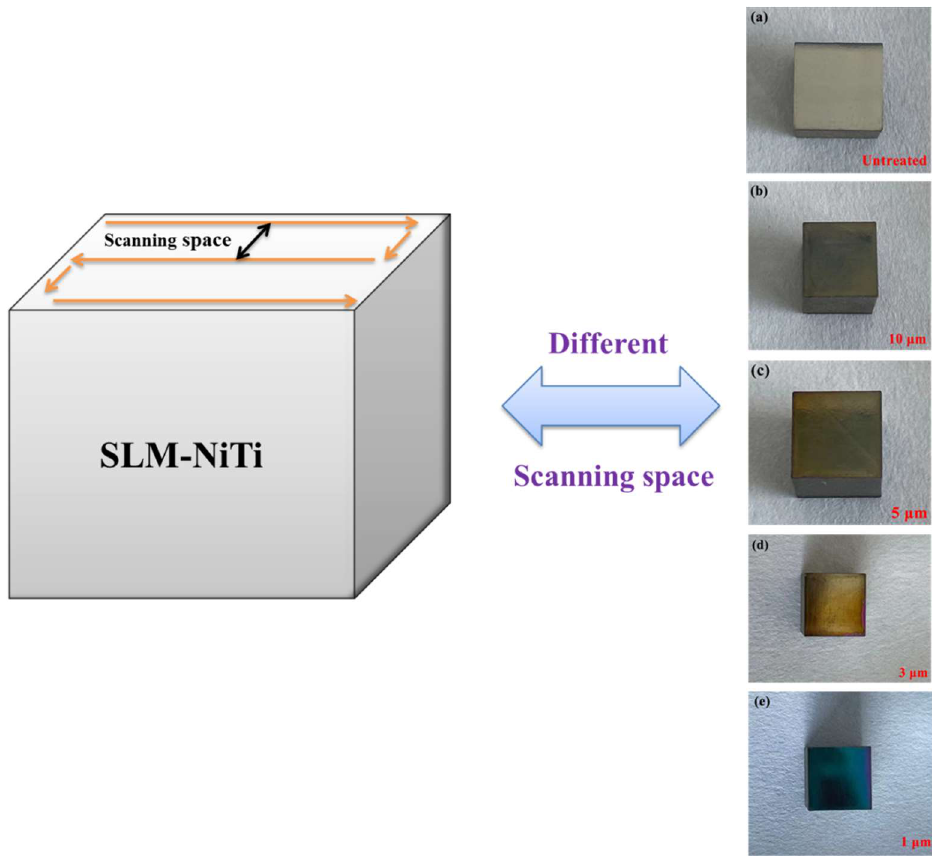
Figure 2. Schematic diagram of femtosecond laser processing path. ( a ) As-fabricated ( b ) 10 μm ( c ) 5 μm ( d ) 3 μm ( e ) 1